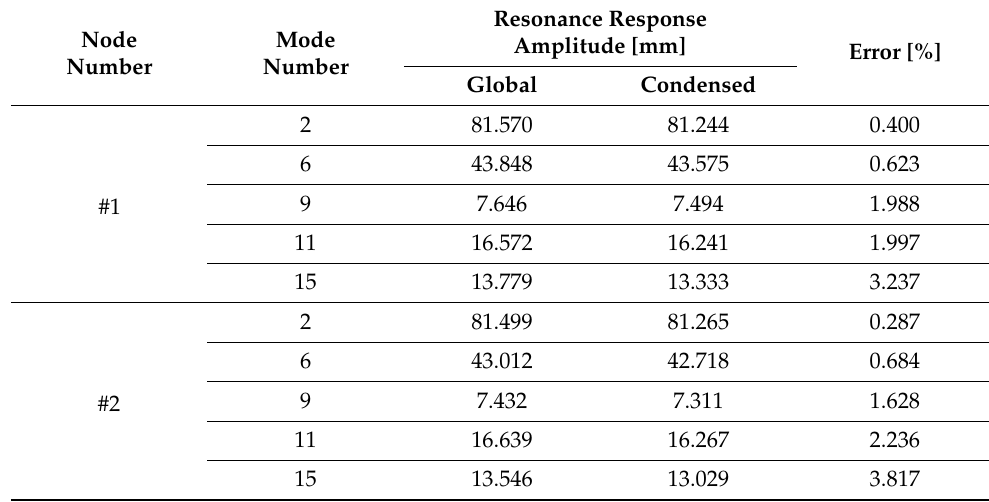
Figure 10. Exact response amplitude ω X ( ) for nodes of interest: ( a ) #1 node and ( b ) #2 node. 0 g Table 3. Response amplitude at resonance and errors between global and condensed models.